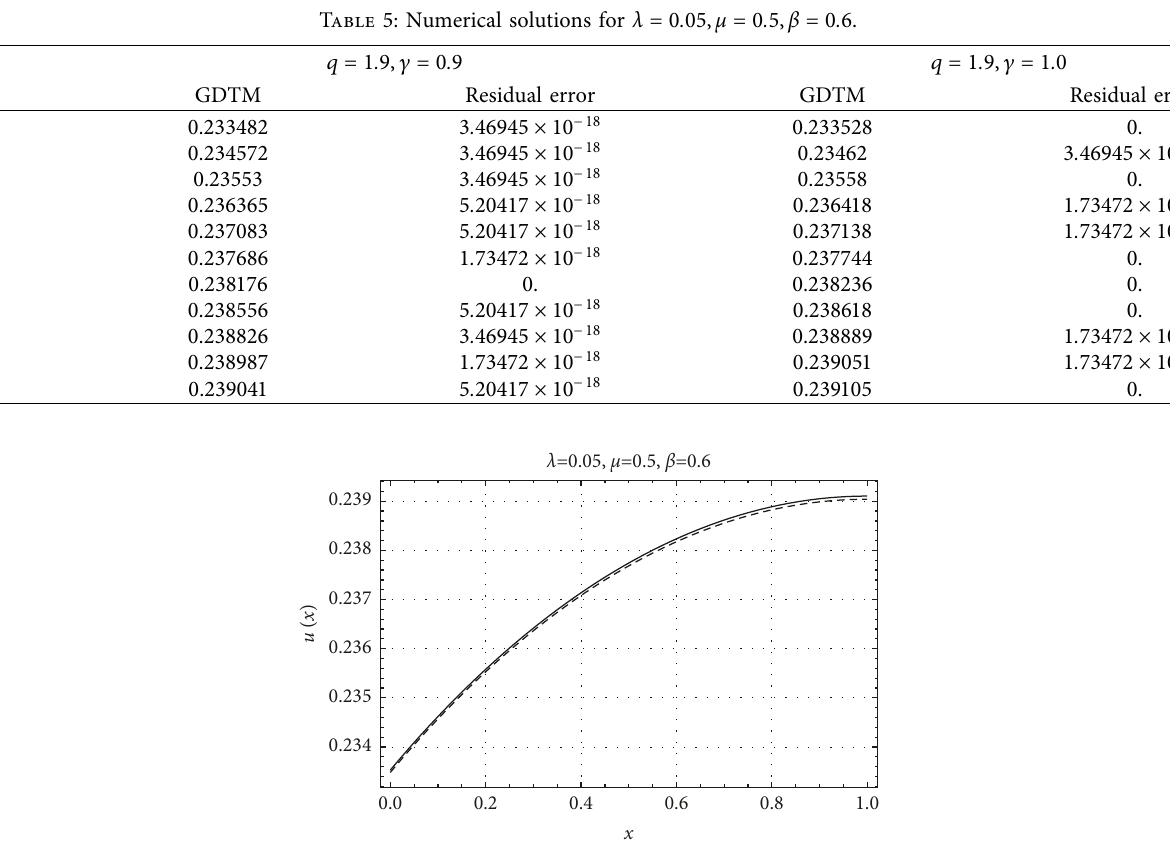
Figure 4: GDTM solution: q � 1 . 9 and c � 1 (line); q � 1 . 9 and c � 0 . 9 (dashed).